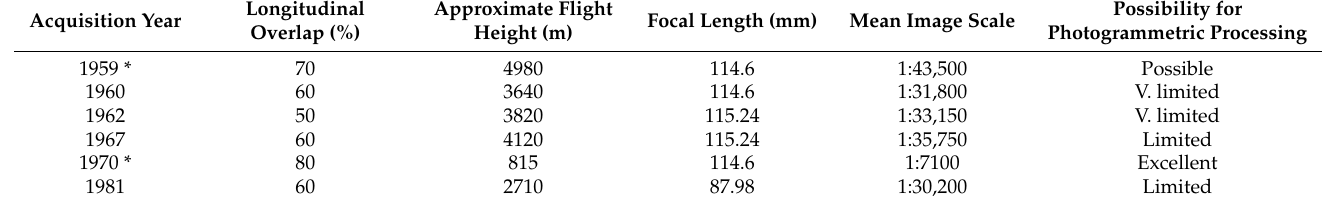
Table 1. The possibility of using historical analog aerial photographs for photogrammetric processing and analysis of the “Umka” landslide. * indicates the sets of photographs that were used during the preparation of this paper.